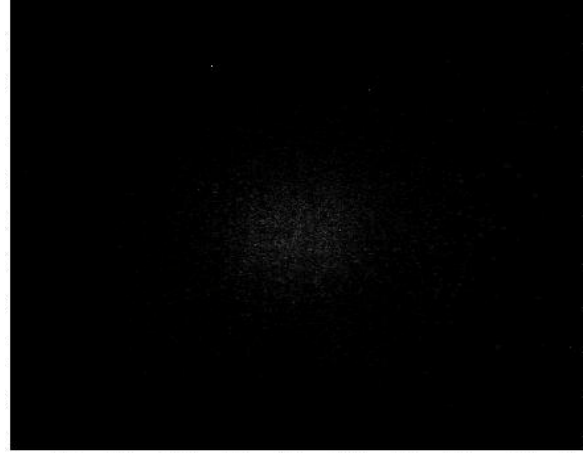
Figure 16. Experiment 1: Sum of a series of 712 images, each filtered, with parallax removed, at 200 mm from the cap face. The summed images show a cross section of the air/particle jet 100.0 cm square.